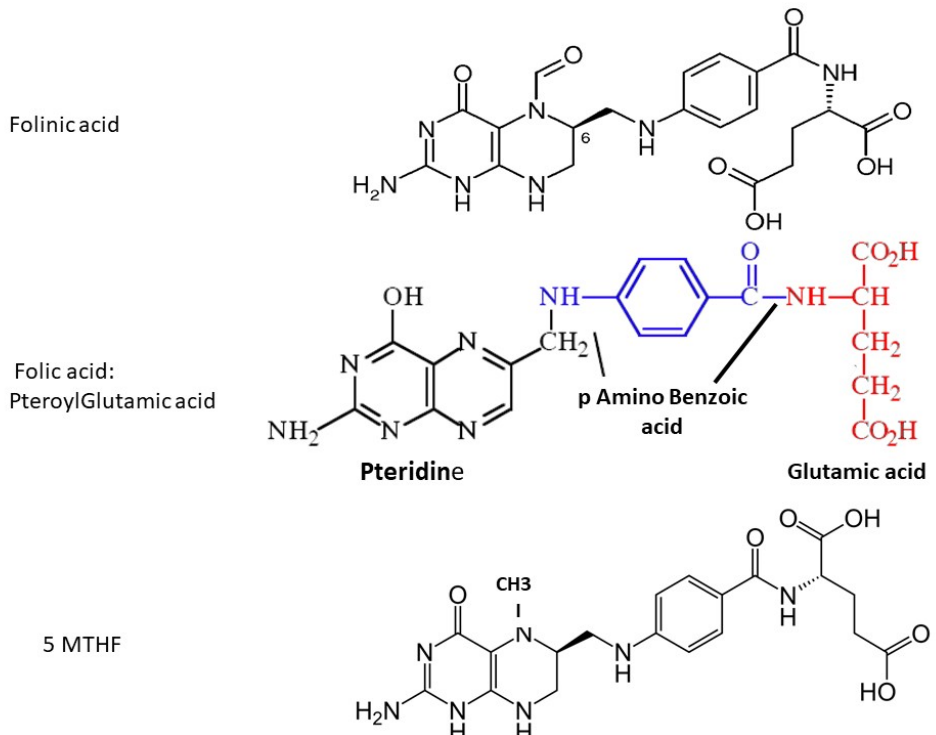
Figure 1. Molecular structure of folinic acid, folic acid and 5-methyltetrahydrofolate; fluorescence- based assays measure the pteroyl group, which is common to all three molecules.